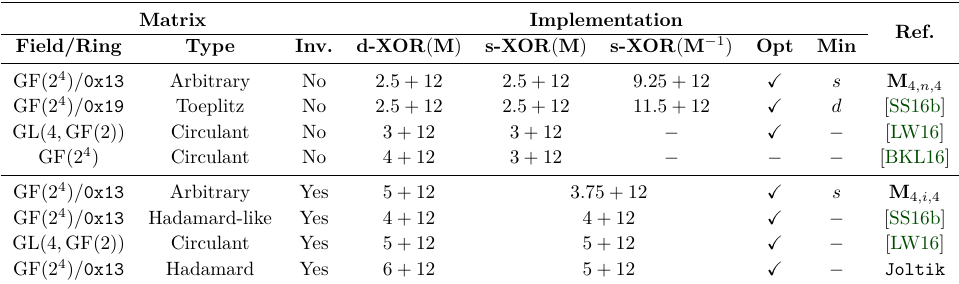
Table 3: Comparison of 4 × 4 MDS matrices over GF(2 4 ) and GL(4 , GF(2)).